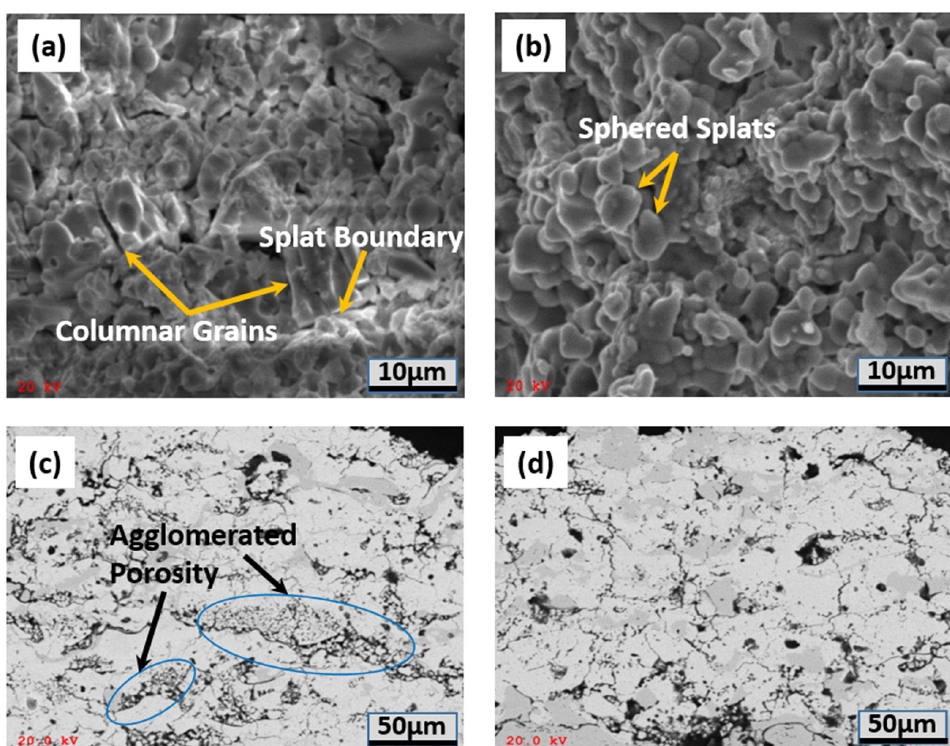
Figure 6. SEM images of the cross-sections of two-phase composite TBCs after isothermal exposure at 1300 °C/100 h: ( a ) fracture morphology of the as-sprayed topcoat; ( b ) fracture morphology of the thermally exposed topcoat; ( c ) microstructure of the as-sprayed topcoat; ( d ) microstructure of the thermally exposed topcoat.